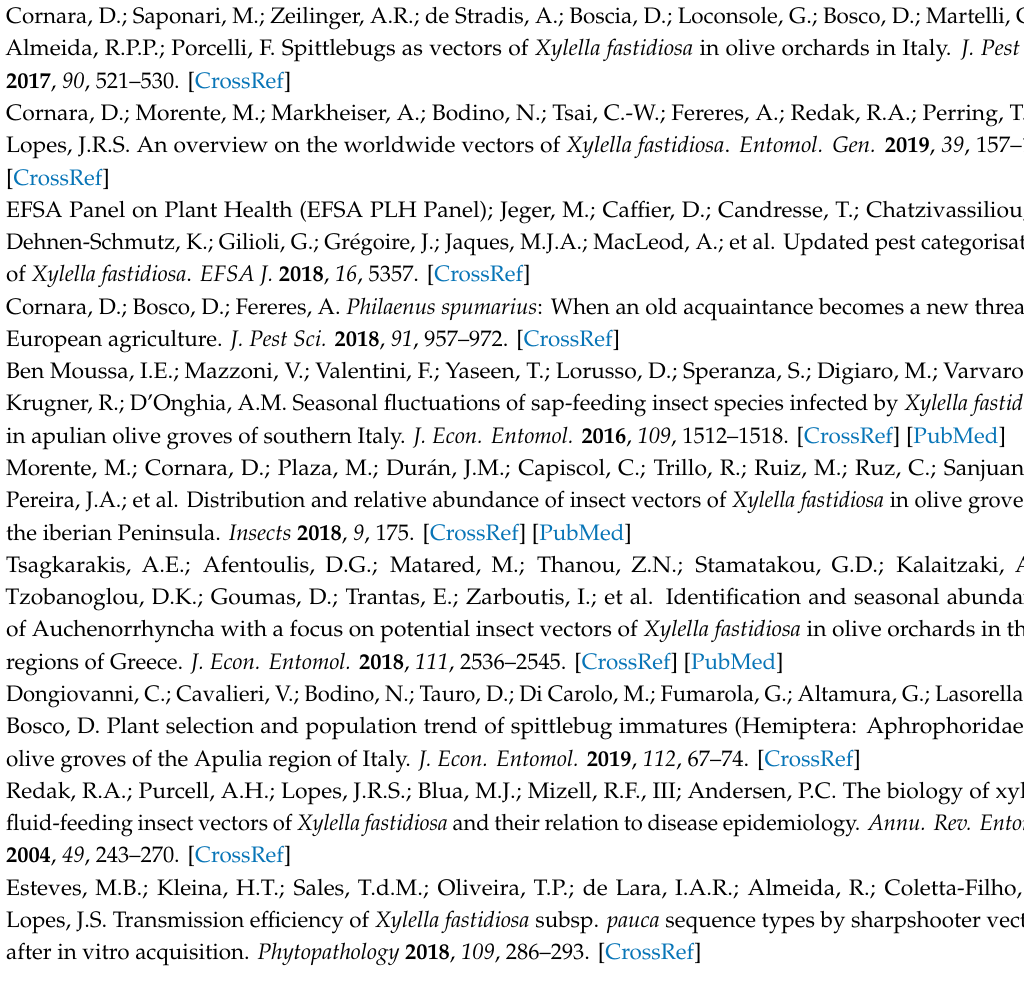
Table S1: No. of Philaenus spumarius nymphs on plant genera and families in Apulia and Liguria olive groves during 2016–2018 sampling campaigns, Figure S1: Relation of mean crowding to mean density of Philaenus spumarius nymphs-per-quadrat in Apulia and Liguria olive groves. Blue line represents fitted values of Iwao’s regression. Black line represents x = y, expectation from Poisson series. Strong outlier data ( > 3rd quartile + 3 × IQR) were